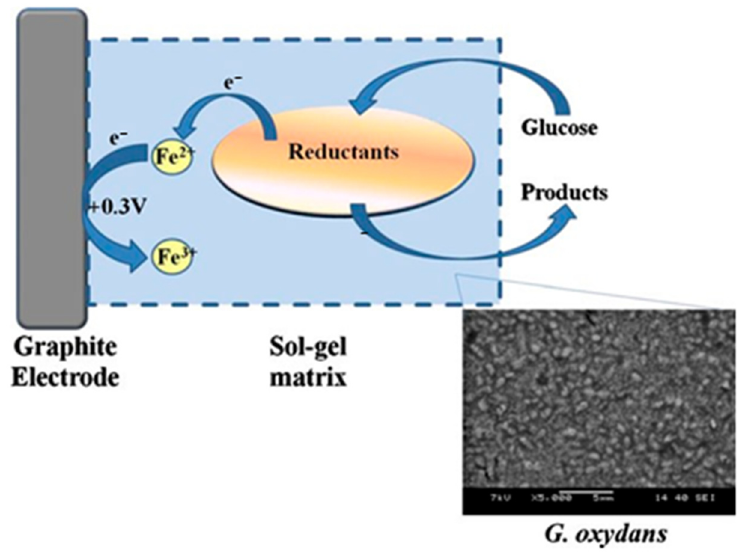
Figure 12. Schematic illustration of the principal microbial biosensor including SEM images of G. oxydans (with ×5000 magnification). Reprinted with permission from [98].